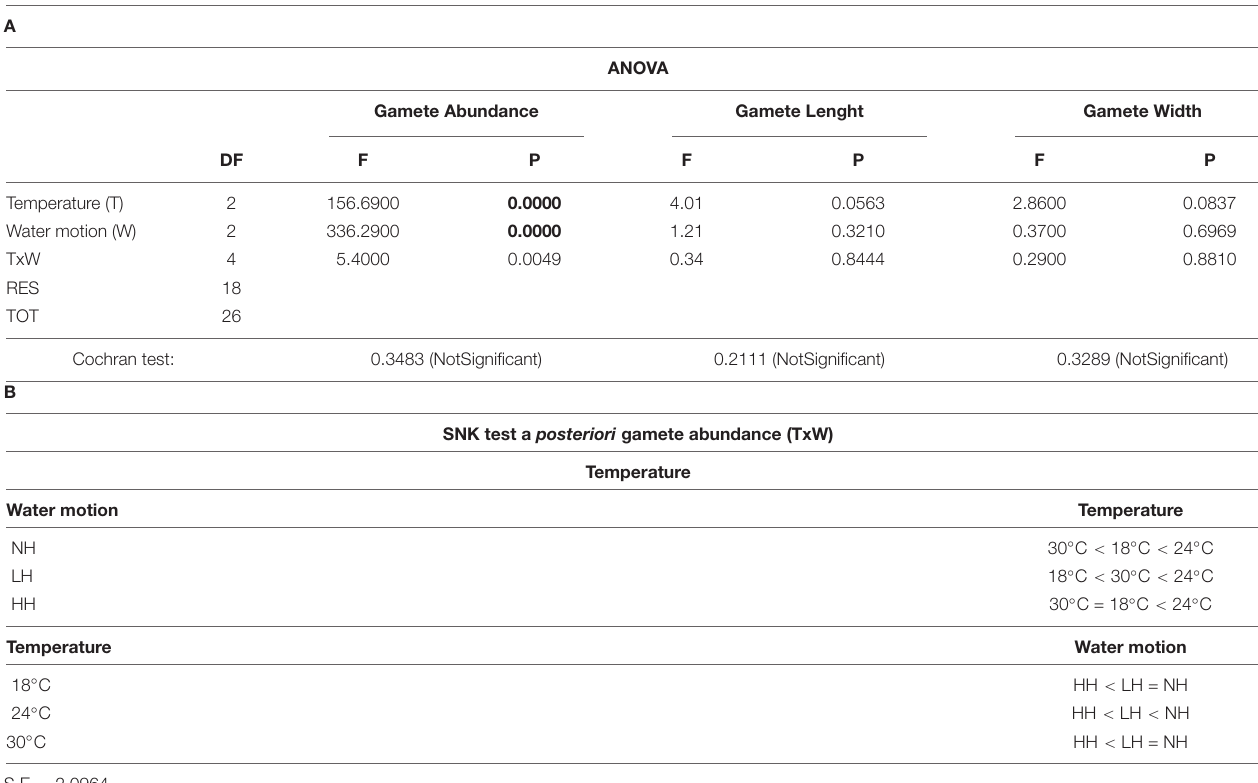
TABLE 3 | (A) Results of the ANOVA on data regarding the abundance, length, and width of gametes in relation to treatments: Temperature (T): 18 vs. 24 vs. 30 ◦ C; Water motion (W): no water motion (NH) vs. low water motion (LH) vs. high water motion (HH).